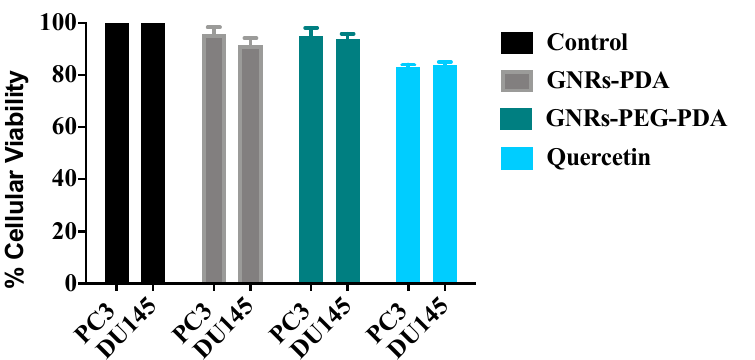
Figure 11. Cellular viability of GNRs containing PDA towards PC3 and DU-145 prostate cancer cells compared to positive and negative controls after scratch assay.